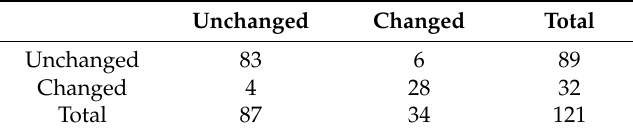
Table 11. Confusion matrix of the ODCD.